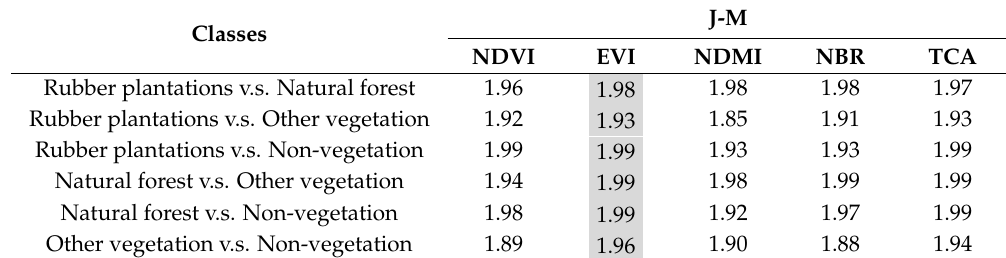
Table 6. The maximum J-M distance between classes when 6 features are selected. Classes